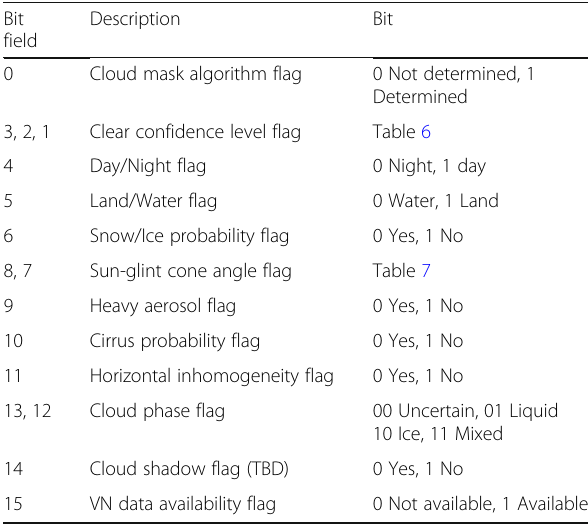
Table 5 Bit fields of the output files for the cloud discrimination algorithm